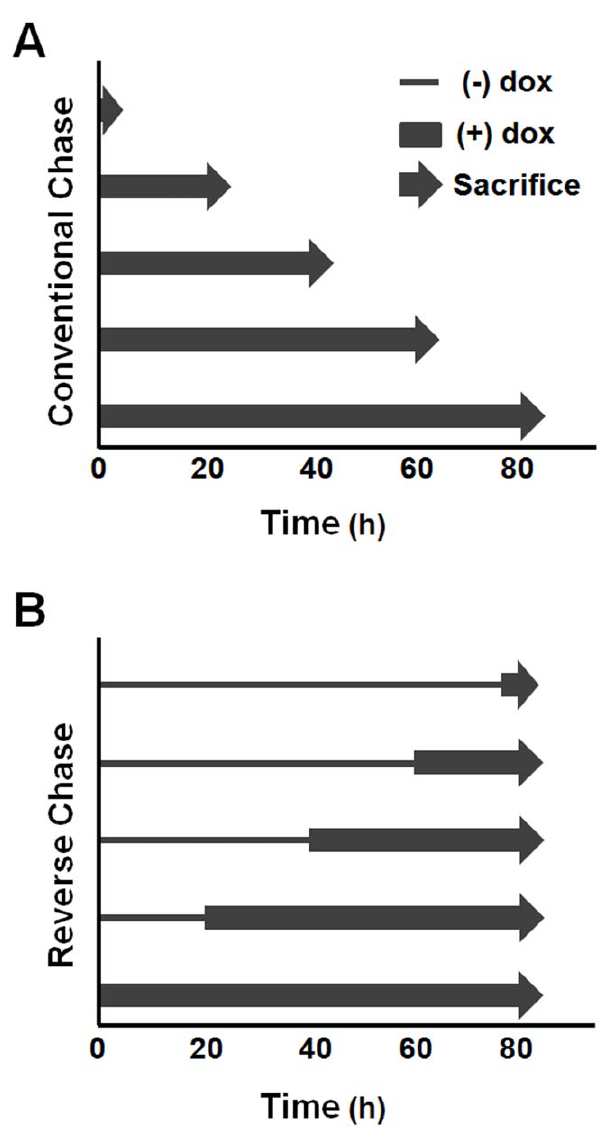
Figure 3. Experimental schemata for transcriptional chase analyses of mRNA stability. (A) Conventional chase method. Identical aliquots cultured in doxycycline (dox)-supplemented media (thick line) are sacrificed at defined intervals (arrowheads). A hypothetical 80-hr chase experiment is illustrated. (B) Reverse-chase method. Identical aliquots cultured in dox-free media (thin line) are amended with dox at defined intervals, and sacrificed simultaneously at the conclusion of the